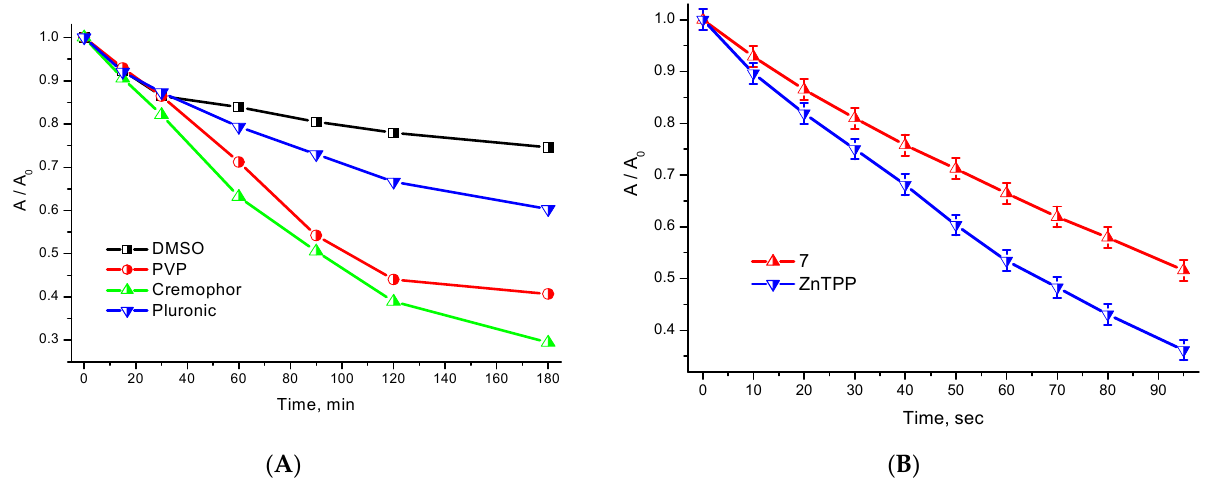
Figure 4. ( A ) Kinetic curves of photobleaching under white light irradiation with respect to 7 in the presence of various solubilizers; ( B ) Kinetic curves of photosensitized DPBF oxidation with singlet oxygen in the presence of 7 and ZnTPP in DMSO.